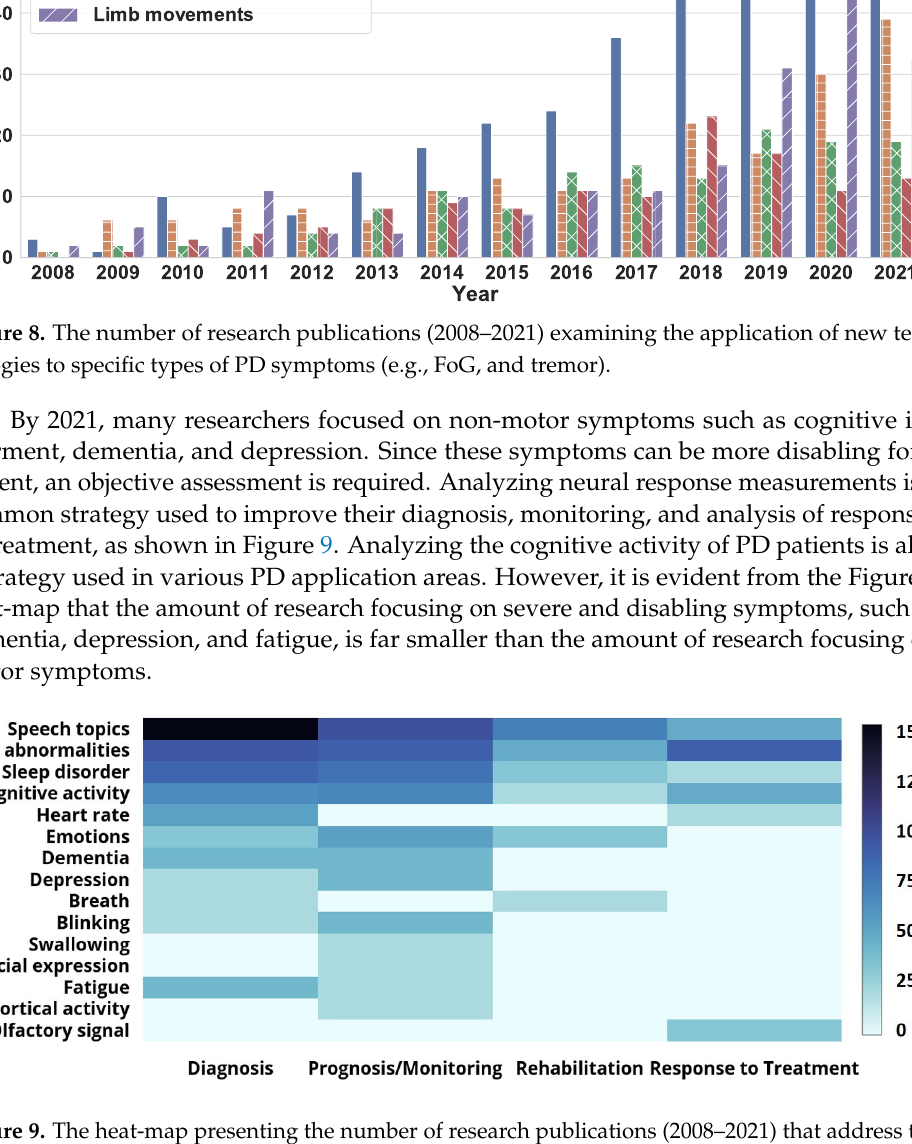
Figure 9. The heat-map presenting the number of research publications (2008–2021) that address the measuring of non-motor PD symptoms (the darker the color, the higher the